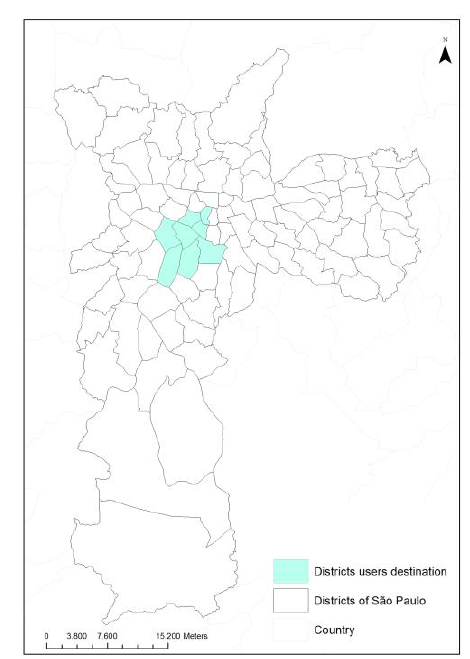
Figure 5. Preferred target districts according to the classes of